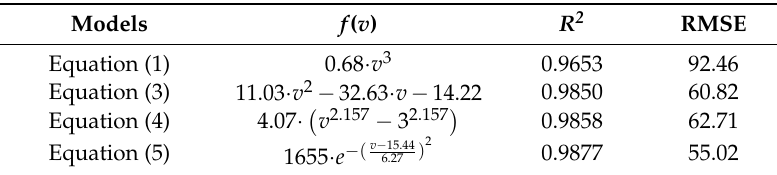
Table 1. Estimated models for the power output.